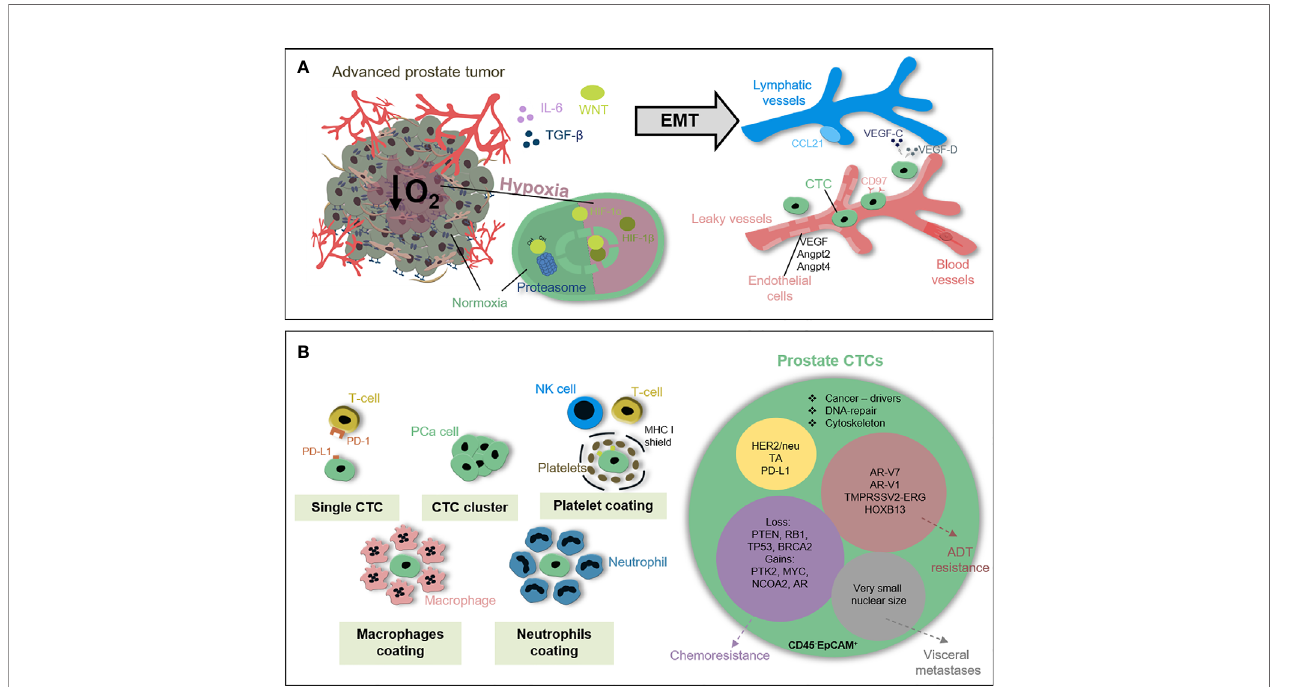
FIGURE 3 | Circulating tumor cells in prostate cancer patients. (A) Early metastatic features within PCa cells can be induced under stress conditions e.g. hypoxia, immune attack, or therapeutic pressure. In response to TGF- b , Wnt or IL-6 PCa cells undergo EMT to gain motility and invasiveness. PCa cells intravasate into blood vessels either passively throughout leaky vessel walls or actively via trans-endothelial migration. (B) Prostate CTCs circulate either as single cells, CTC cluster, or coated with platelets, neutrophils or macrophages shielding immune attack and reducing shear stress. CD45 - EpCAM + CTCs are a heterogeneous population differing in, e.g. the expression of androgen receptor splice variants, TMPRSS2-ERG status or loss of tumor suppressors PTEN, RB1, and TP53 recapitulating local tumor heterogeneity, in fl uencing metastatic capacity and indicating therapy